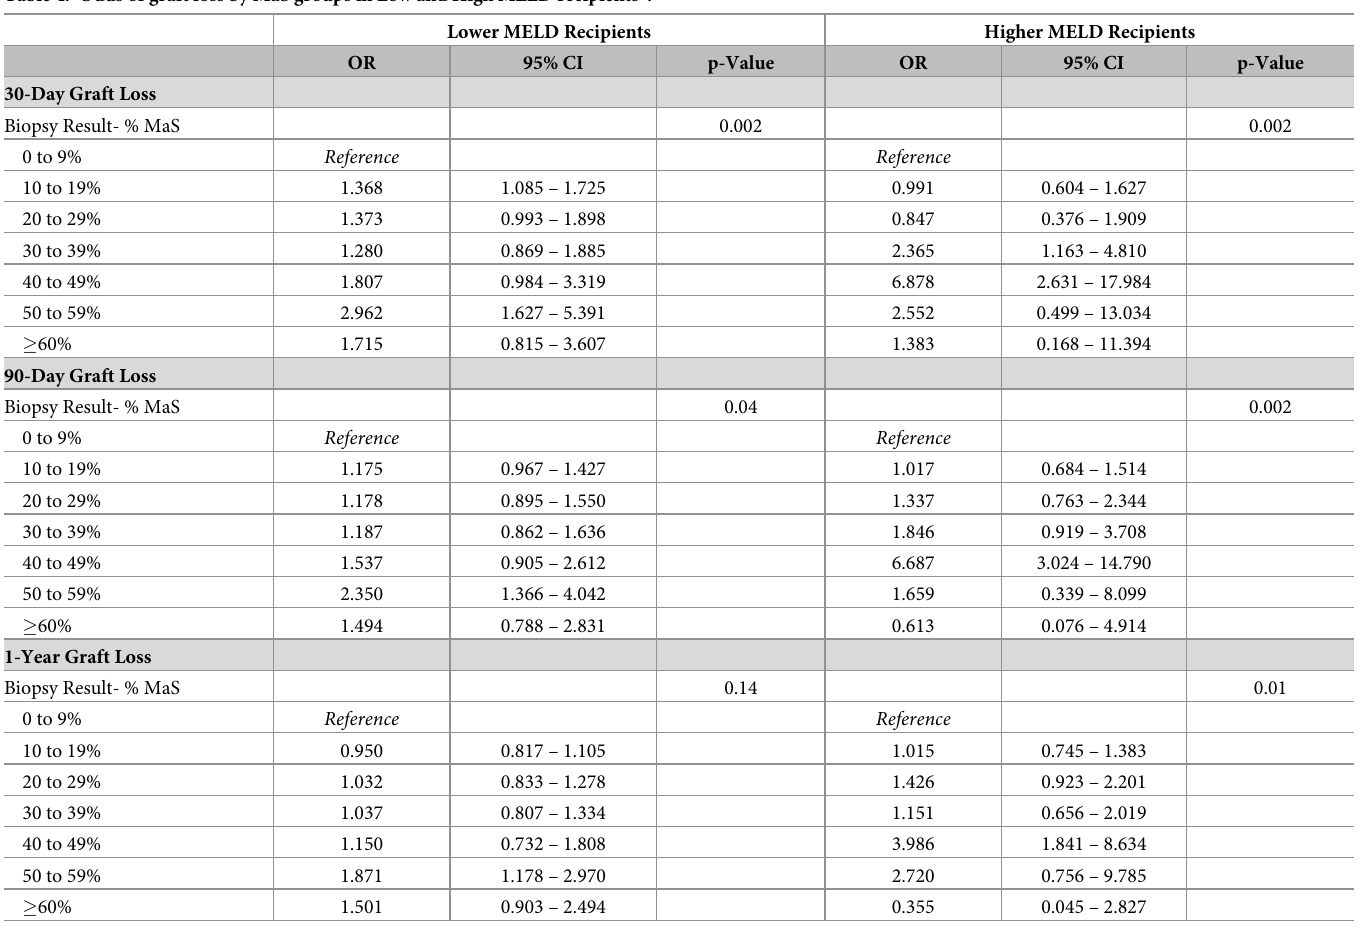
Table 4. Odds of graft loss by MaS groups in Low and High MELD recipients �